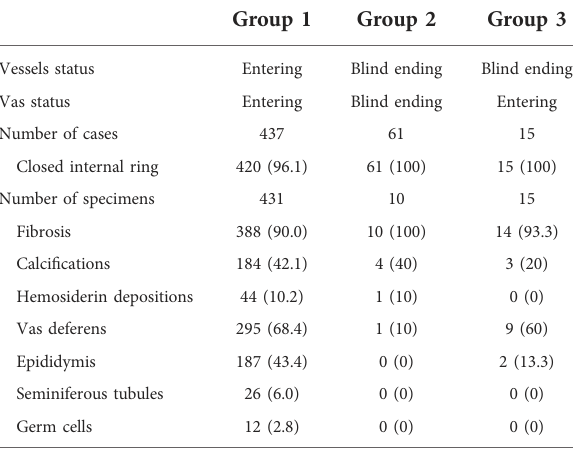
TABLE 1 Summary of the intraoperative and pathologic fi ndings in the laparoscopic